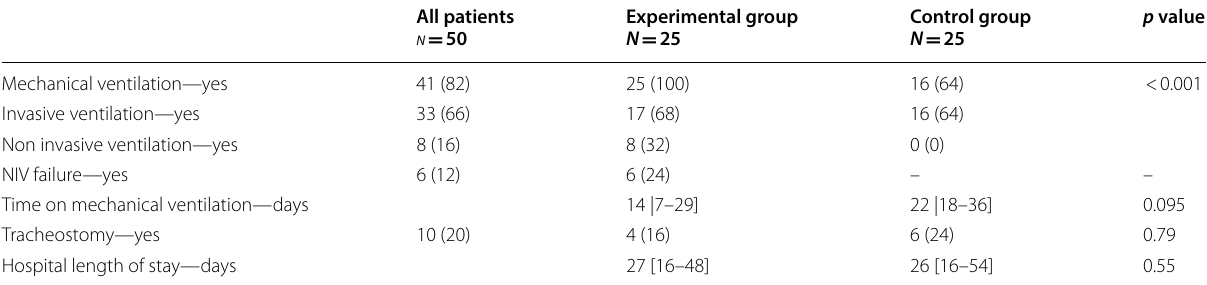
Data are expressed as number (percentage) for categorical variables and as median [interquartile range] for continuous variables